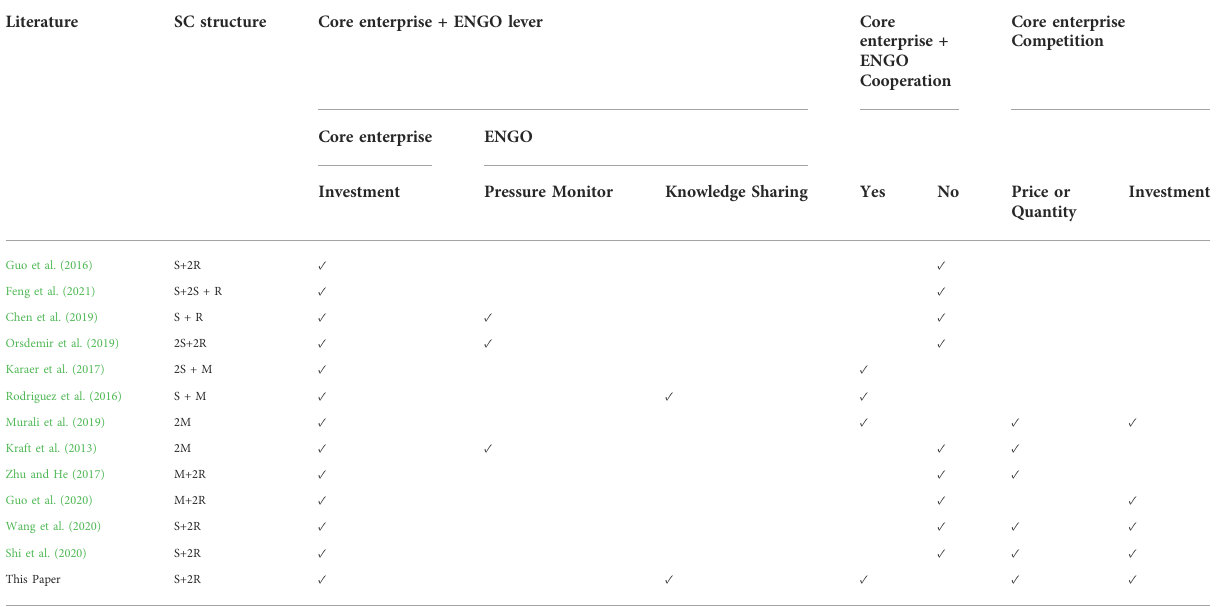
TABLE 1 Comparison between previous related studies and our present study.